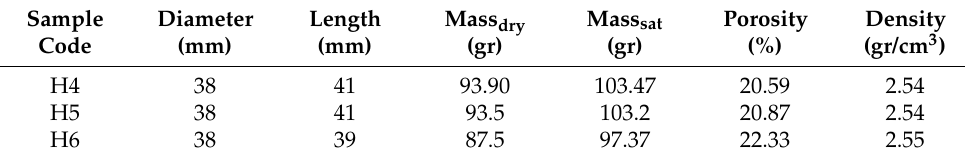
Table 4. Properties on High-porosity sandstone specimens for AVS